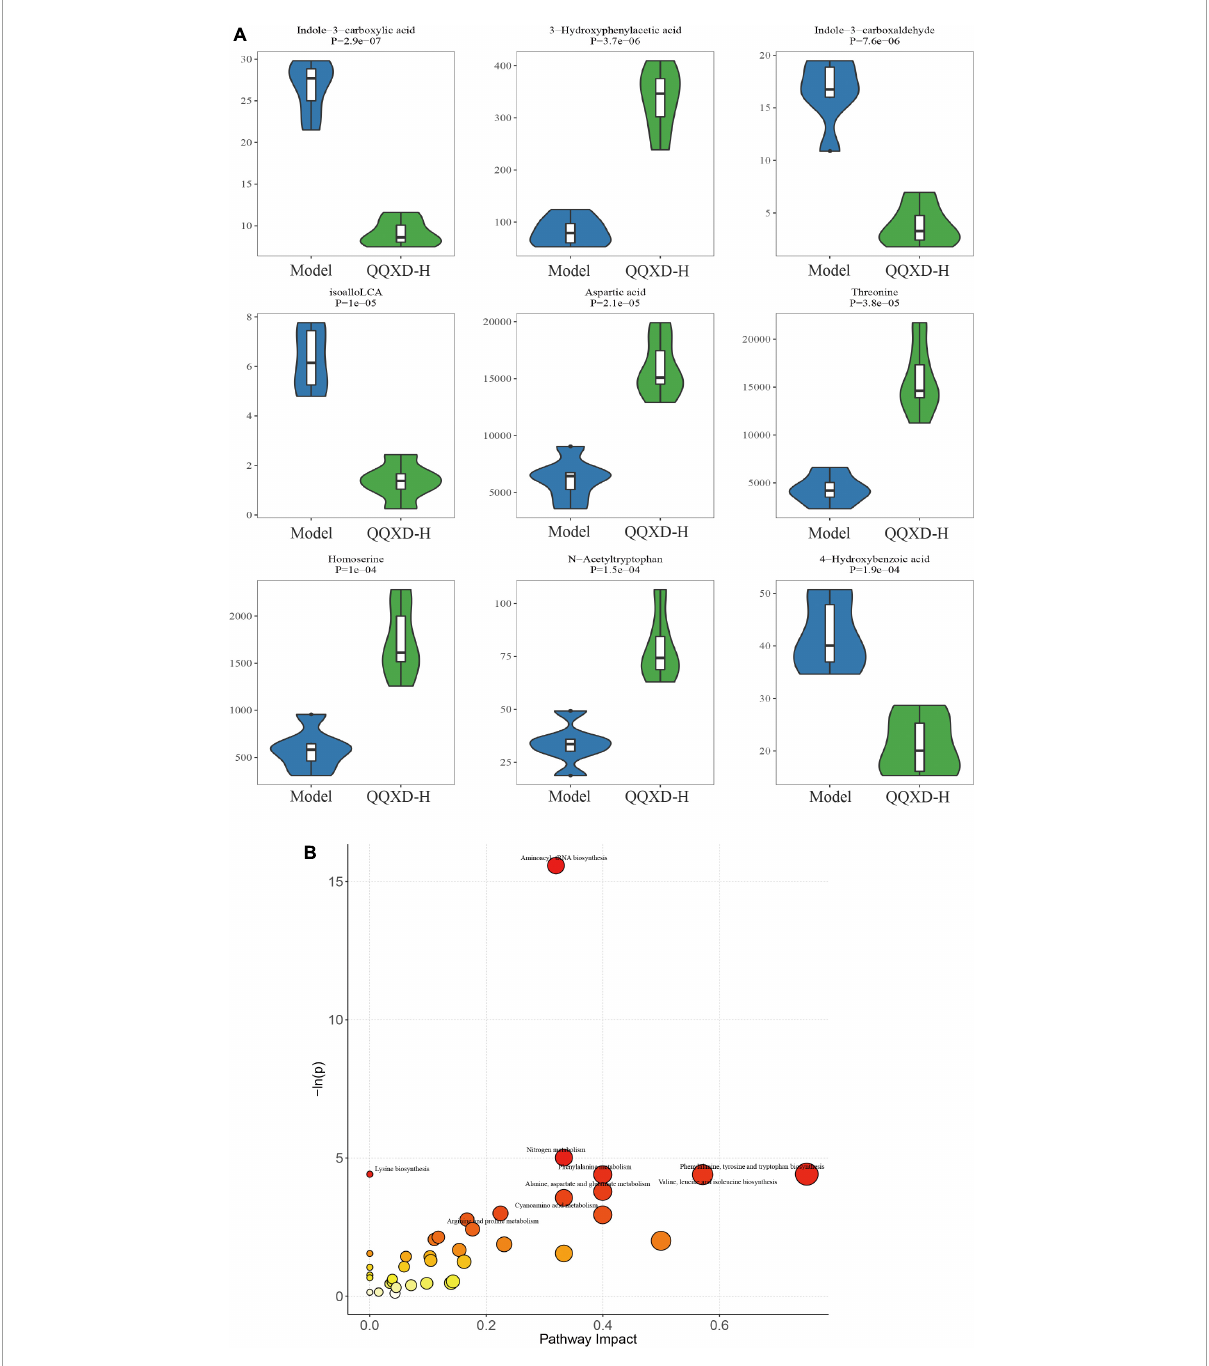
FIGURE7 Differential metabolites and pathway analysis. (A) Violin diagram of differential metabolites. (B) Path analysis bubble chart.